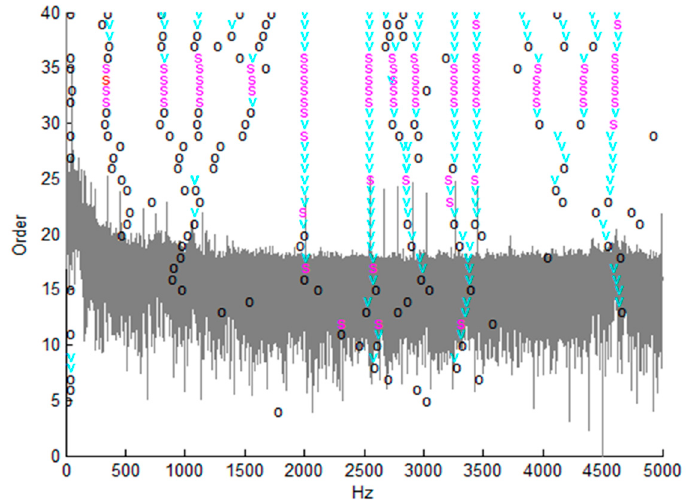
Figure 8. System dynamics in low frequencies masked by the system behaviour in the higher fre- quencies.